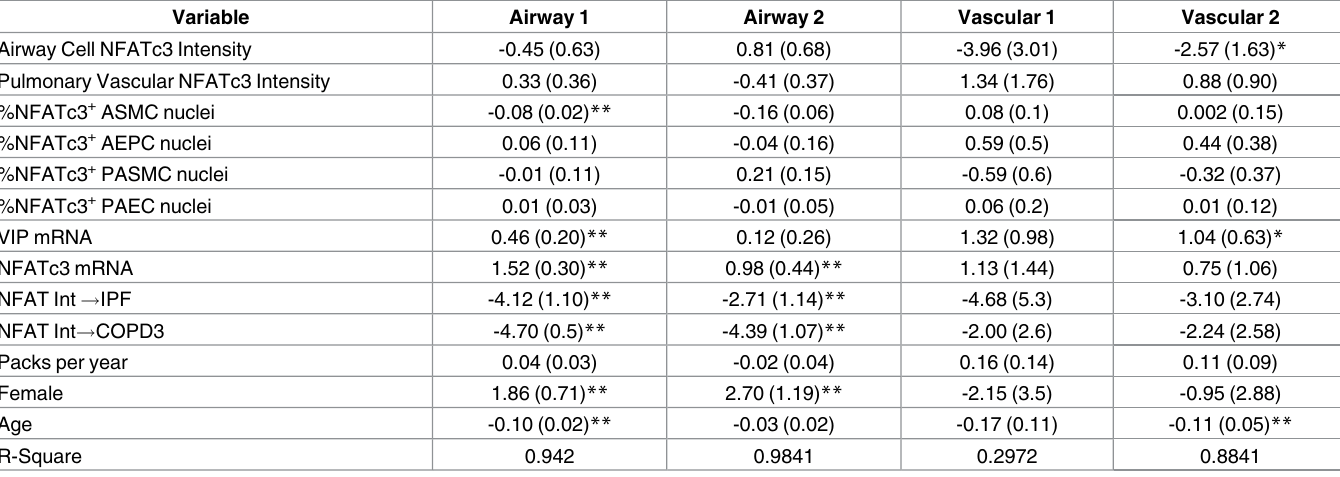
inhibiting NFATc3 nuclear import [38] further supporting a role for NFATc3 in CH-induced pulmonary hypertension in rats. Contrary to our expectations, we found no significant differ- ences in NFATc3 expression and/or activity among patients with different degrees of severity Table 3. Remodeling Outcomes Using All Intensity Indicators Working Through Disease.